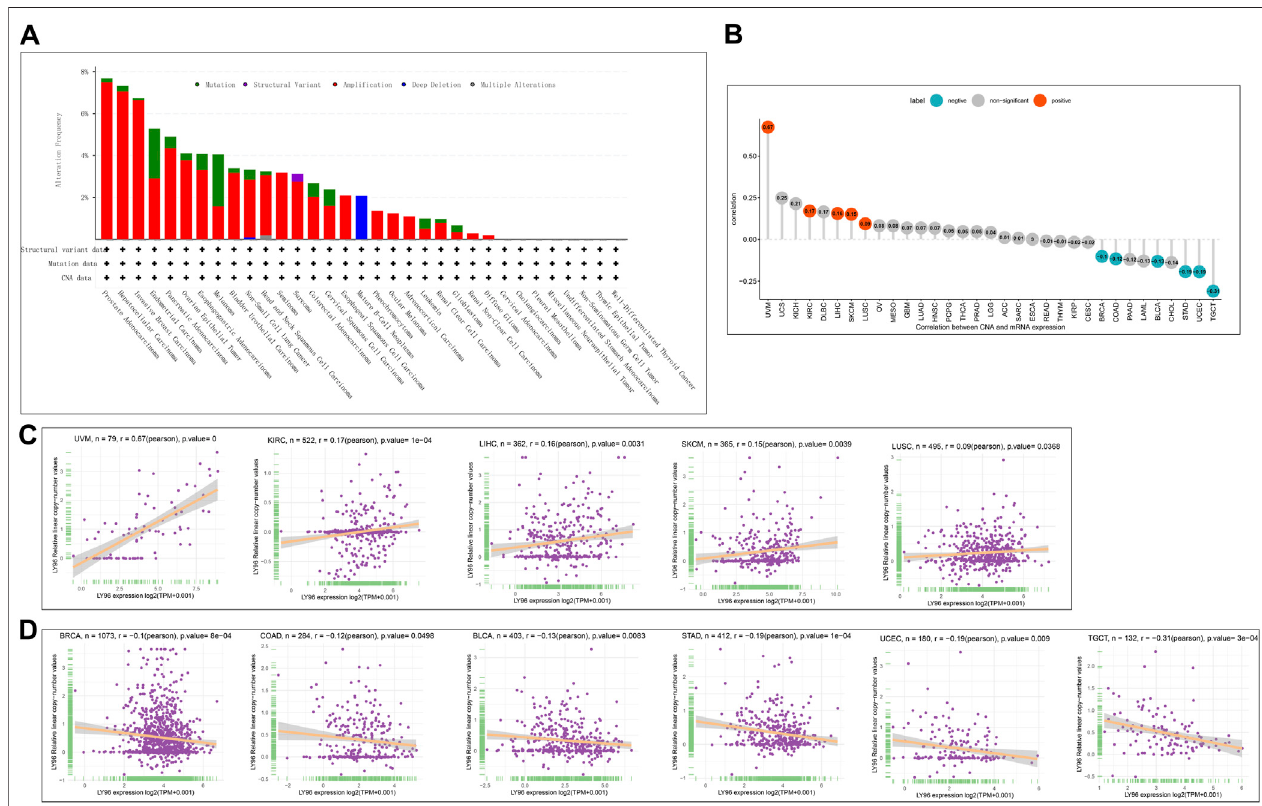
FIGURE 5 | Correlation between LY96 expression and copy number variation (CNV). (A) CNV of LY96 across cancers. (B) Correlation between LY96 expression and CNV. (C) LY96 expression was positively correlated with CNV in uveal melanoma (UVM), kidney renal clear cell carcinoma (KIRC), liver hepatocellular carcinoma (LIHC), skin cutaneous melanoma (SKCM), and lung squamous cell carcinoma (LUSC). (D) LY96 expression was negatively correlated with CNV in testicular germ cell tumors (TGCT), uterine corpus endometrial carcinoma (UCEC), stomach adenocarcinoma (STAD), bladder urothelial carcinoma (BLCA), colon adenocarcinoma (COAD), and breast invasive carcinoma